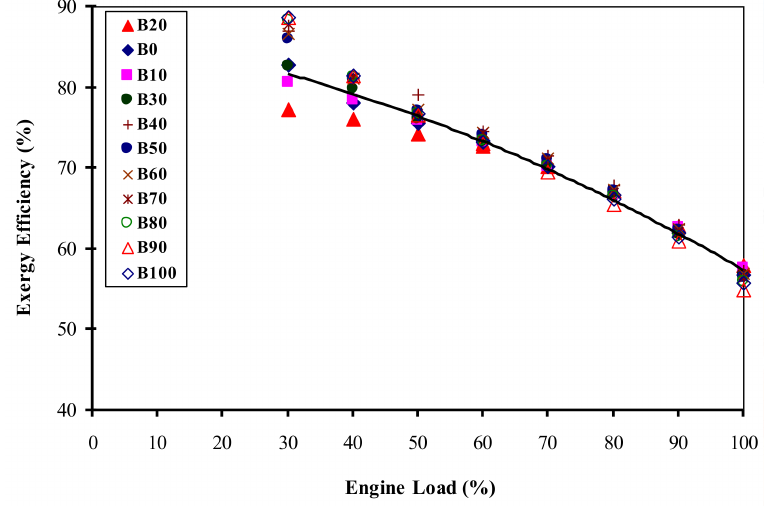
Figure 6. Exergy efficiency of the